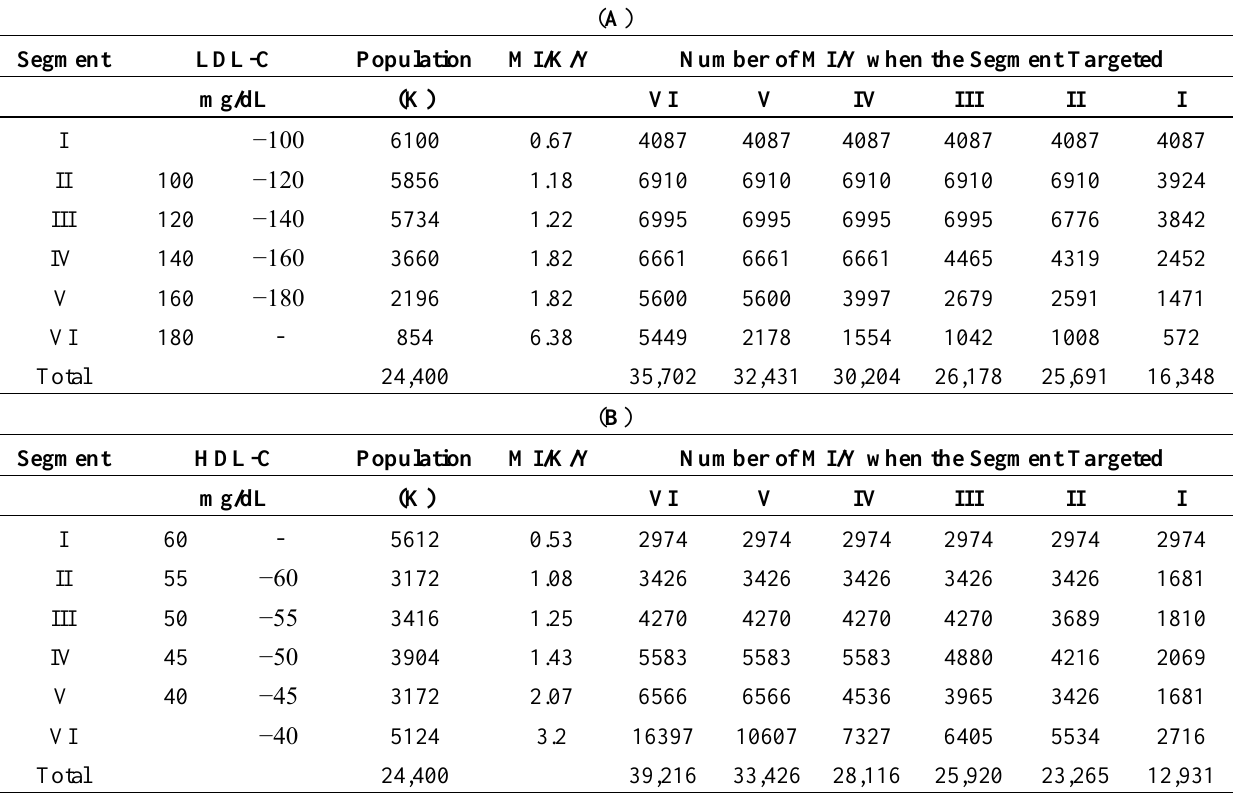
cholesterol (HDL-C;